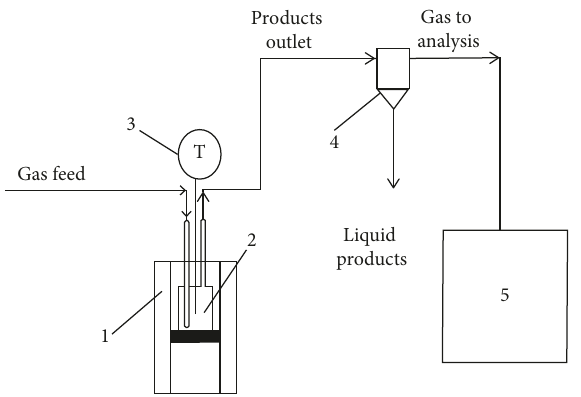
Figure 2: Diagram of the experimental installation of convective heating. 1: radial oven convective heating; 2: quartz reactor; 3: temperature regulator; 4: cooled separator; 5: